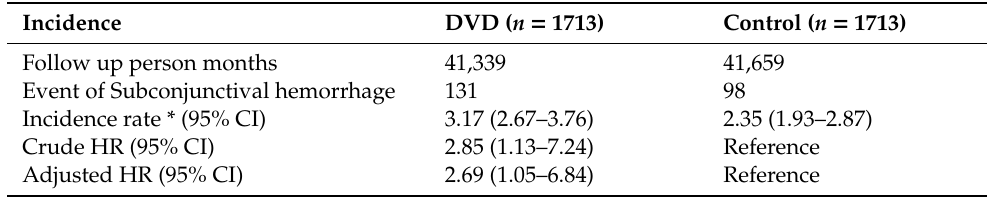
Table 2. Incidence risk of subconjunctival hemorrhage between the study group and the matched control